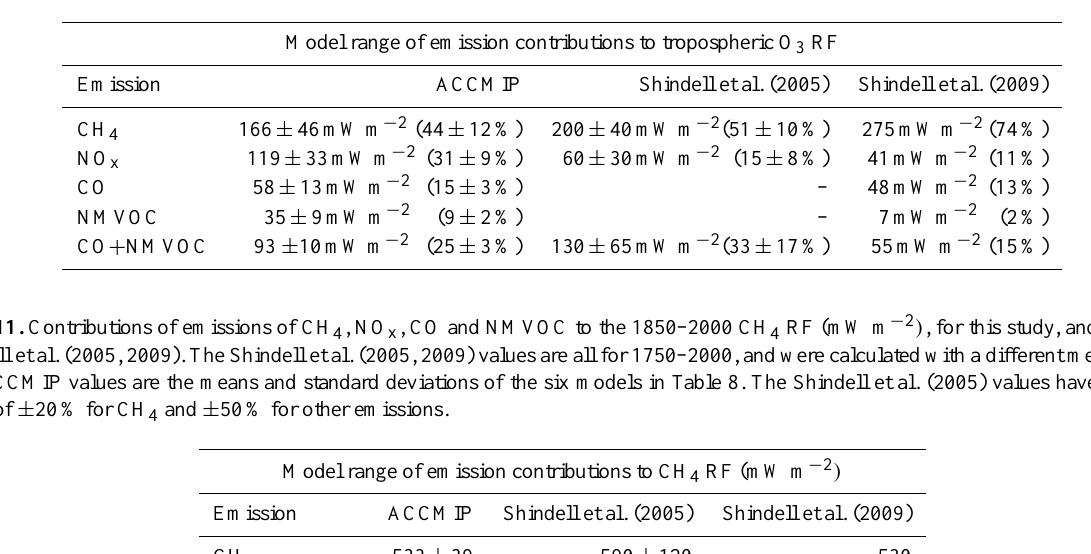
Table 10. Contributions of emissions of CH 4 , NO x , CO and NMVOC to the 1850–2000 O 3 RF, in both absolute terms (mW m − 2 ) and as percentages, for this study, and also from Shindell et al. (2005, 2009). The Shindell et al. (2005, 2009) values are all for 1750–2000, and are instantaneous RFs calculated using a different methodology. The ACCMIP values are the means and standard deviations of the six models in Table 8. The Shindell et al. (2005) values have estimated errors of ± 20% for CH 4 and ± 50% for other emissions.